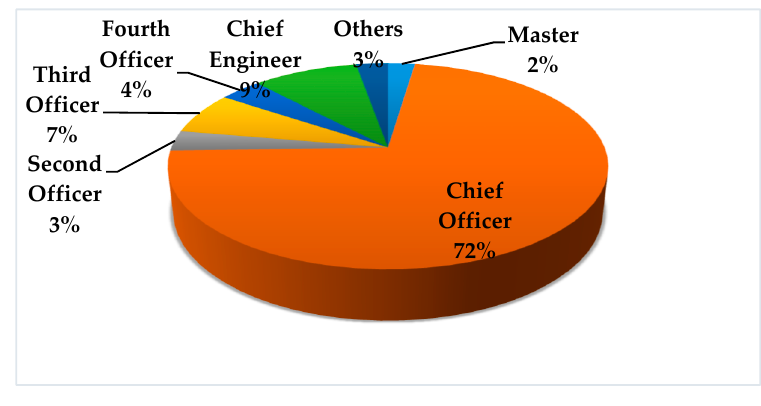
Figure 2. Near-miss reporters.